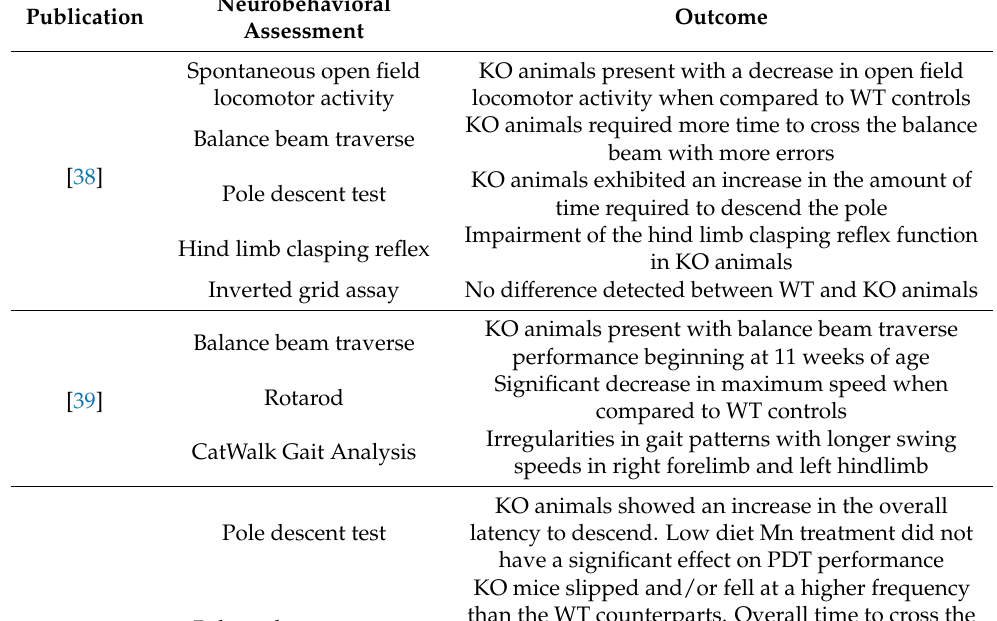
Table 1. Neurobehavioral assessments and their outcomes in Slc39a14-KO